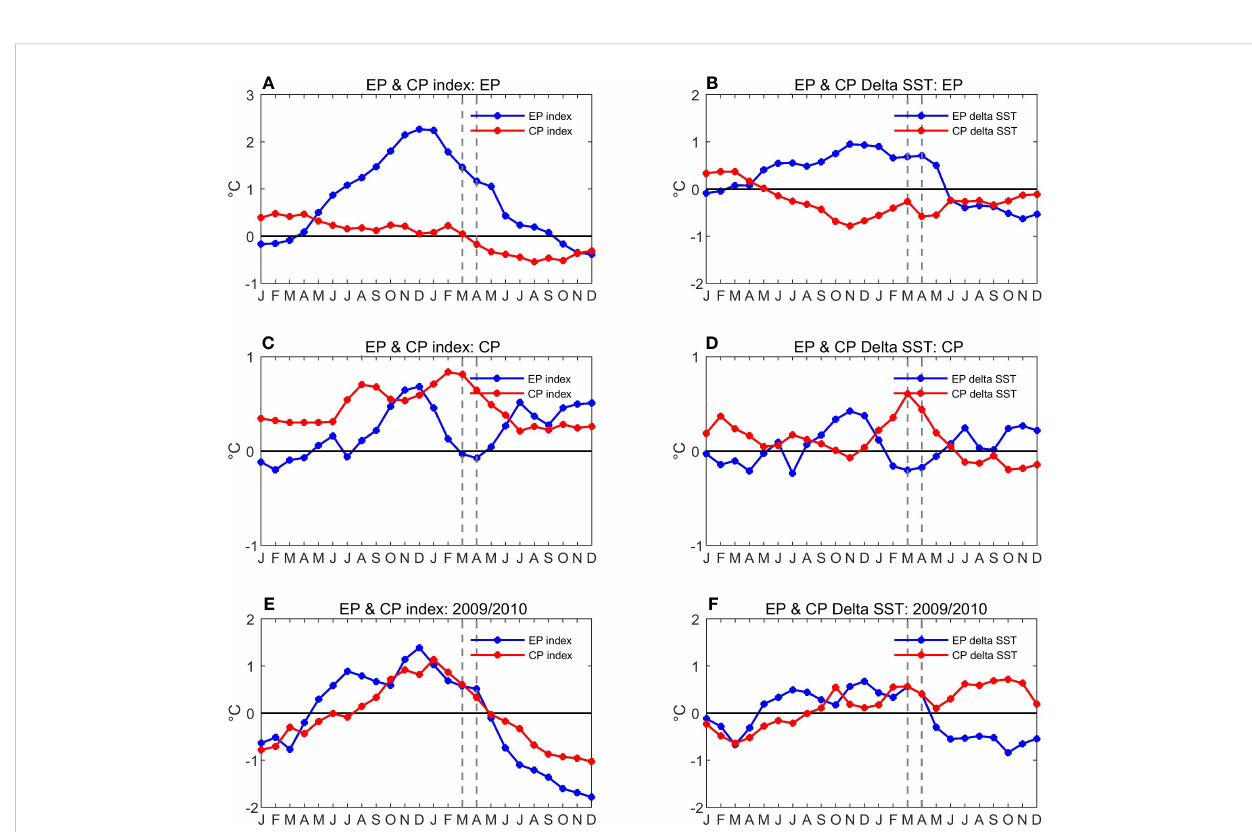
FIGURE 10 Time evolution of EP and CP index (sub fi gures of left column) for: (A) the composite of EP-type El Niños; (C) the composite of CP-type El Niños and (E) the 2009/2010 mixed-type El Niño. Time evolution of zonal-mean EP-type and CP-type delta SST (sub fi gures of right column) for: (B) the composite of EP-type El Niños; (D) the composite of CP-type El Niños and (F) the 2009/2010 mixed-type El Niño.